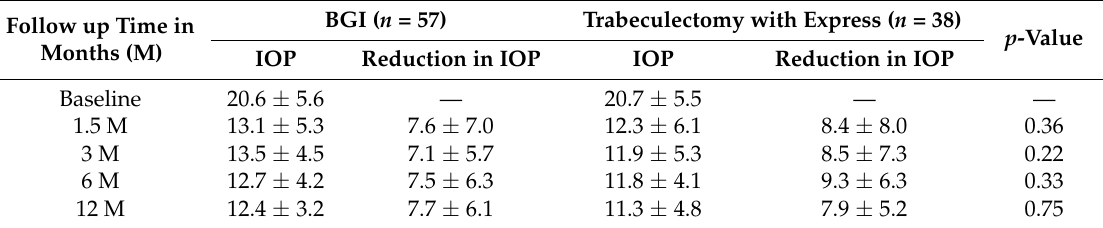
Table 2. Intraocular pressure (IOP) and IOP